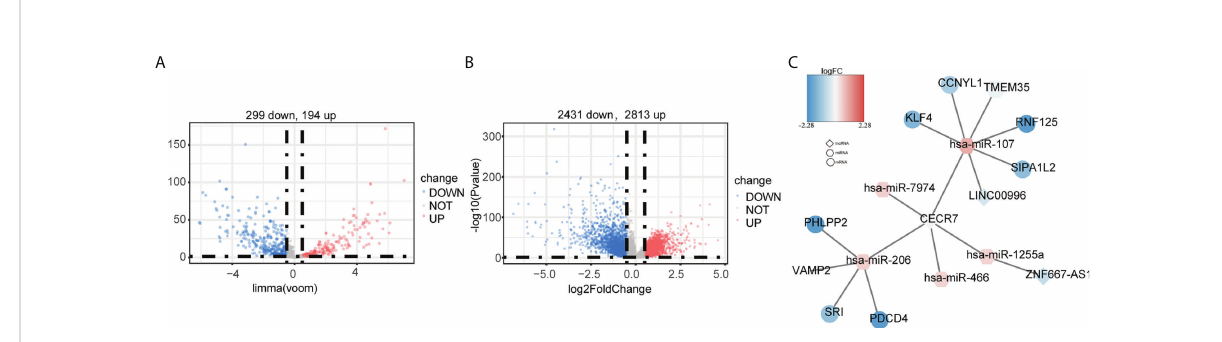
FIGURE 9 Construction of the ceRNA network based on the six hypoxia-immune – related lncRNAs. (A) Identi fi cation of differentially expressed miRNAs between cancer and normal tissues in TCGA. (B) Identi fi cation of differentially expressed mRNAs between cancer and normal tissues in TCGA.